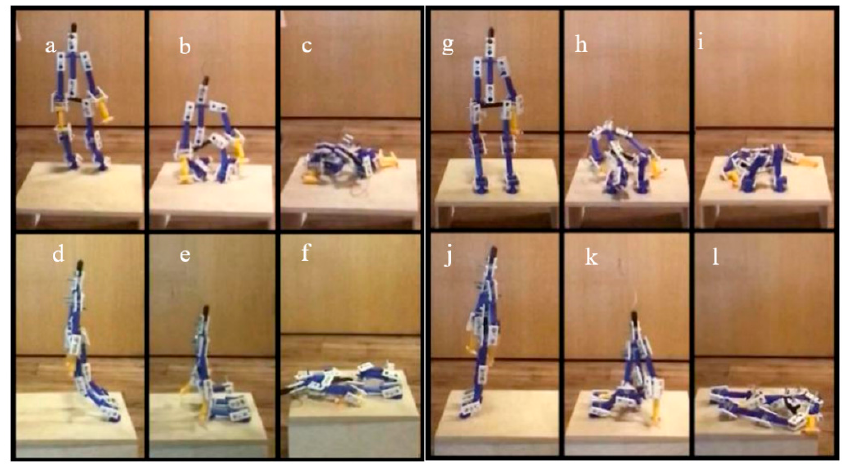
Figure 7. The process for forward and backward fall. ( a ) Front of the first step of forward fall; ( b ) Front of the second step of forward fall; ( c ) Front of the third step of forward fall; ( d ) The left side of the first step of forward fall; ( e ) The left side of the second step of forward fall; ( f ) The left side of the third step of forward fall; ( g ) Front of the first step of backwards fall; ( h ) Front of the second step of backwards fall; ( i ) Front of the third step of backwards fall; ( j ) The left side of the first step of backwards fall; ( k ) The left side of the second step of backwards fall; ( l ) The left side of the third step of backwards fall.